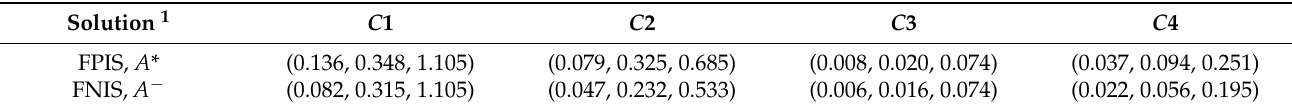
Table 12. Fuzzy Positive Ideal Solution (FPIS) and Fuzzy Negative Ideal Solution (FNIS) for the military students’ opinion of the quality of these